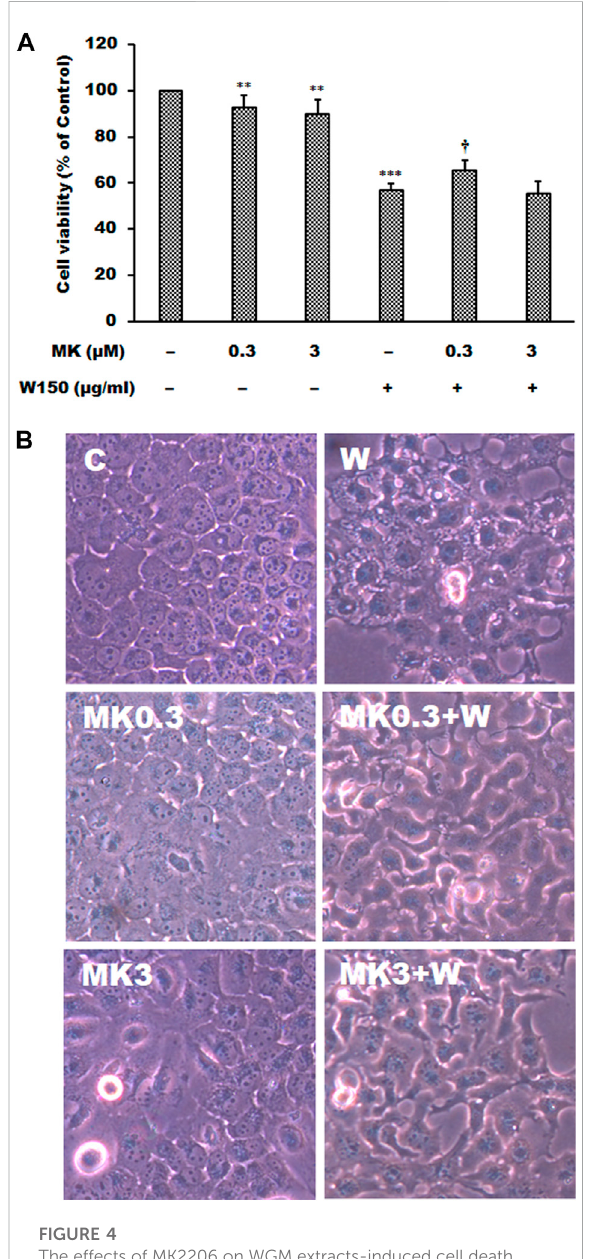
FIGURE 4 The effects of MK2206 on WGM extracts-induced cell death and membrane-enclosed vacuoles of Hep3B cells. Cells were pretreated with 0.3 or 3 μ M MK2206 (MK) for 1 h and then treated with 0.1% DMSO or 150 μ g/ml WGM extracts (W) for 24 h. (A) The effects of MK2206 on WGM extracts-induced cell death of Hep3B cells. After treatment, the viable cells were measured by MTT assay. All determinations are expressed as the mean % control ±S.D. of duplicate from three independent experiments. ** p < 0.01, *** p < 0.001 compared to the control values. † p < 0.05 compared to the WGM extracts alone. (B) The effects of MK2206 on WGM extracts-induced membrane-enclosed vacuoles of Hep3B cells. After treatment, the cells were immediately photographed with an Olympus IX 73 phase-contrast microscope. All results are representative of three independent experiments.